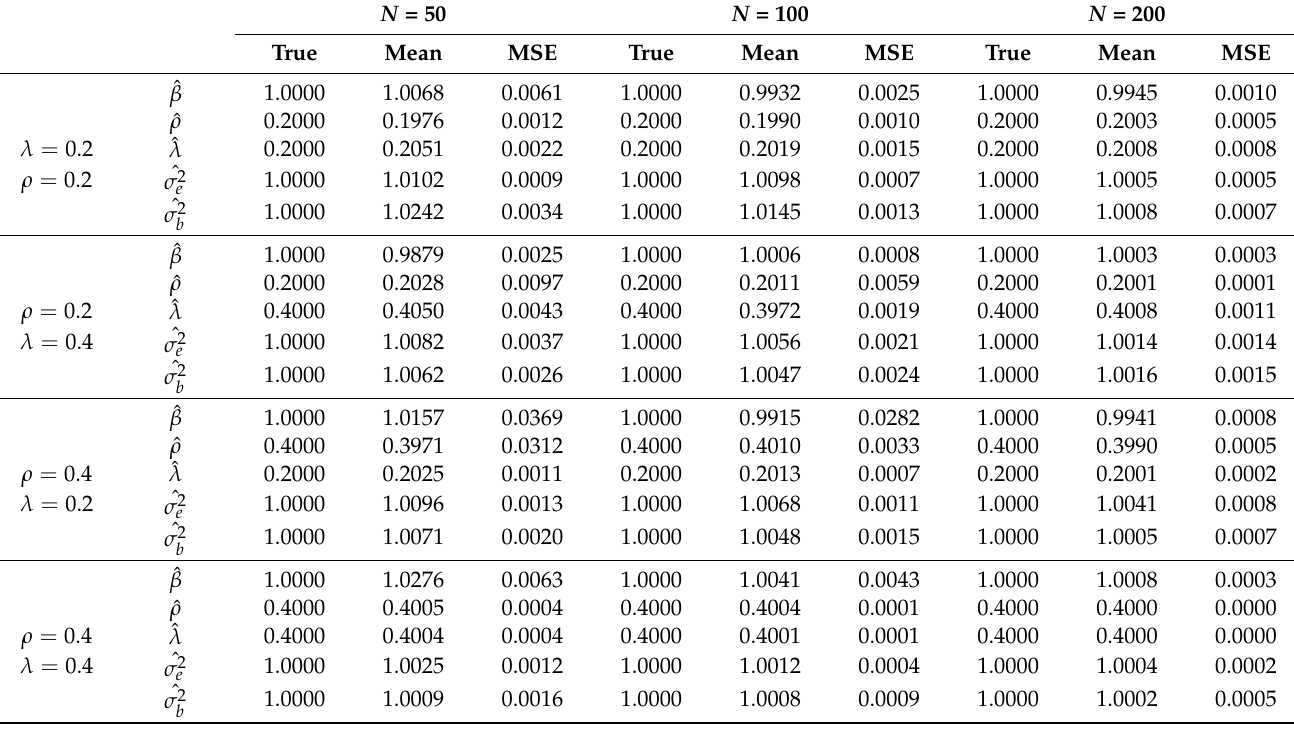
Table 2. Results of parametric estimates under the model (12) with T = 20.